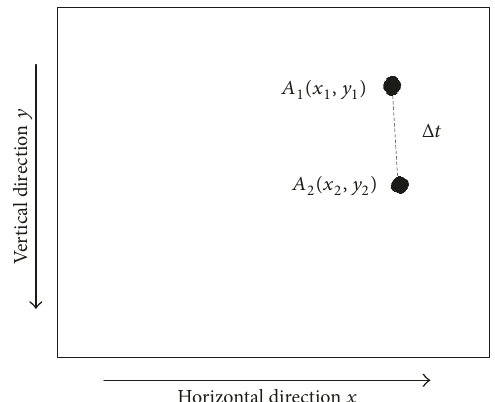
Figure 6: The diagram of the velocity extraction